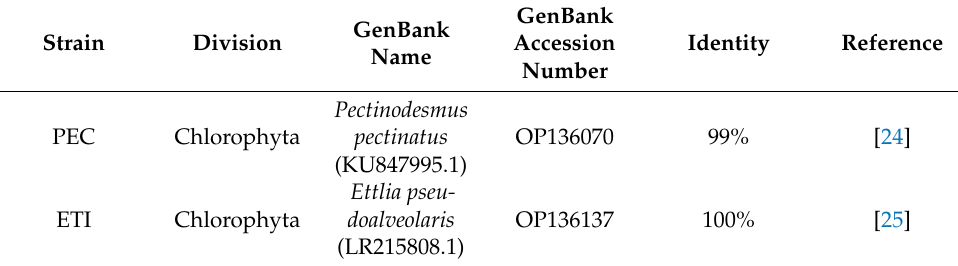
Table 1. List of microalgal strains sequenced in this